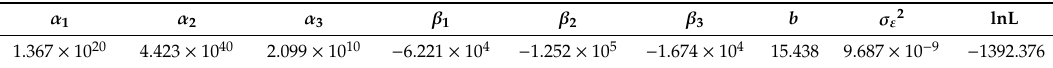
Table 4. Estimated values of unknown parameters for accelerometers.